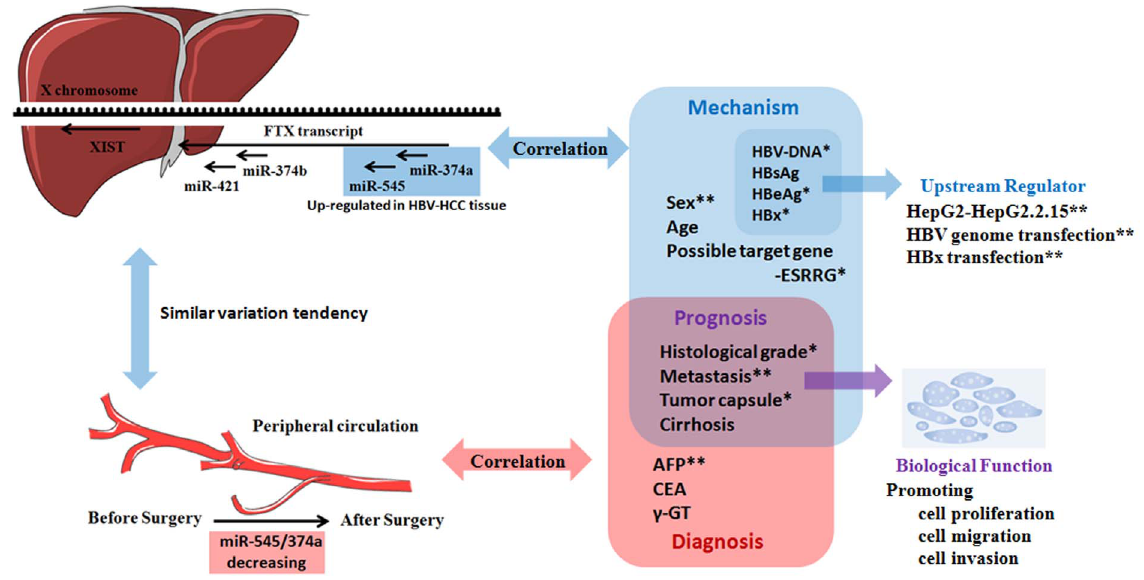
Figure 6. A consolidated model for the role of the miR-545/374a cluster in human HBV related hepatocellular carcinoma. Ftx gene encodes a lncRNA which harbors 2 cluster of microRNAs in its introns, the miR-374a/545 cluster and the miR-374b/421 cluster. In clinical specimens, the miR-545/374a cluster is upregulated in HCC tissue and is significantly correlated with prognosis-related clinical features. Serum miR-545/374a are tumor-derived, and their expression are significantly decreased after surgical excision of tumor tissue. MicroRNA 545 and miR-374a are both higher in male HCC patients compared to female HCC patients, and ESRRG may be a target gene of miR-545. In vitro studies, the miR-545/374a cluster promotes HCC cell proliferation, cell migration and invasion. Expression of miR-545/374a is positively regulated by HBV infection and may be induced by HBx expression.